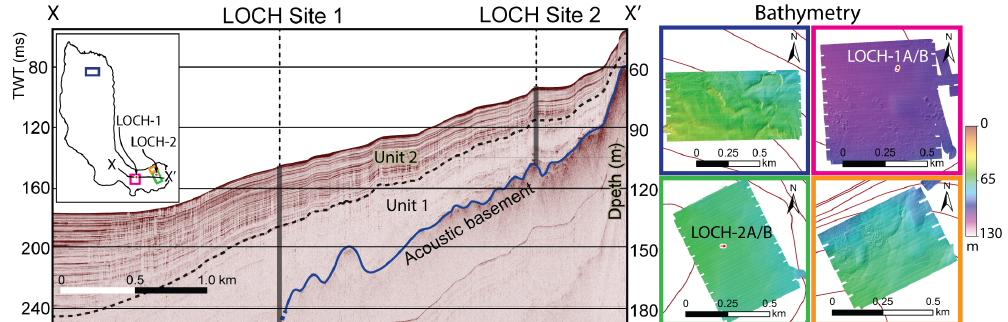
Figure 3. Seismic (boomer) reflection profile and sonar data from Lake Ohau showing the progressive thickening of the post-glacial sequence toward the central lake basin. The inset map shows the location of profile X–X (cid:48) , LOCH drill sites (red dots), and bathymetric surveys (coloured squares correspond to data shown at the right of the